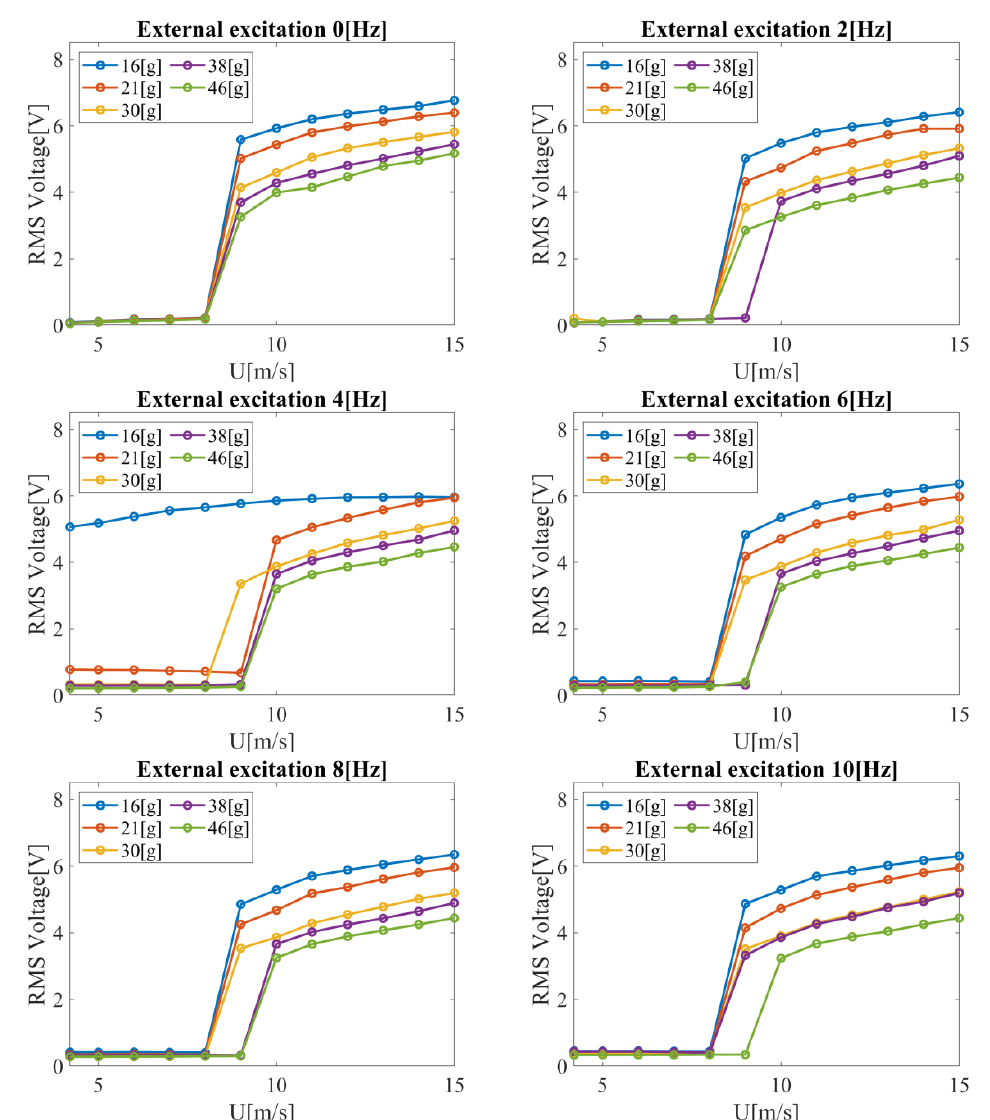
Figure 5. RMS voltage on the piezoelectric element as a function of air flow velocity for the considered bluff body